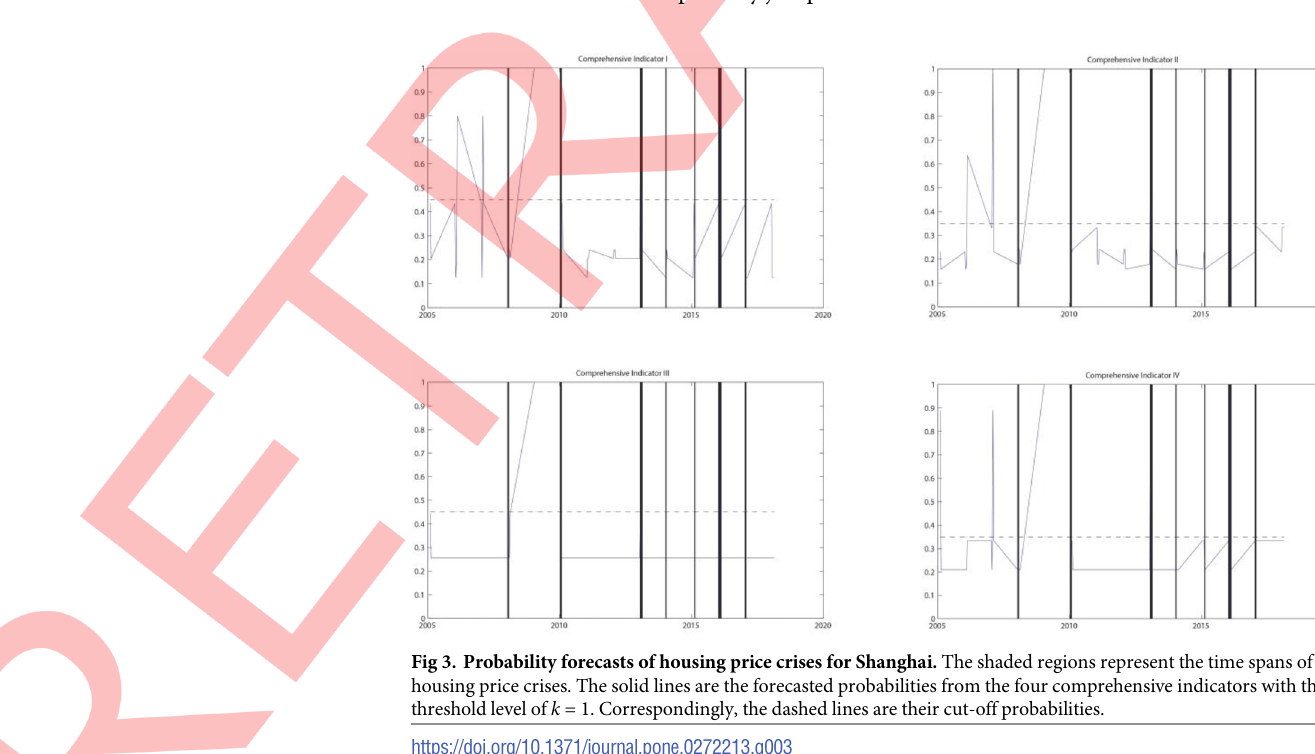
Fig 3. Probability forecasts of housing price crises for Shanghai. The shaded regions represent the time spans of housing price crises. The solid lines are the forecasted probabilities from the four comprehensive indicators with the threshold level of k = 1. Correspondingly, the dashed lines are their cut-off